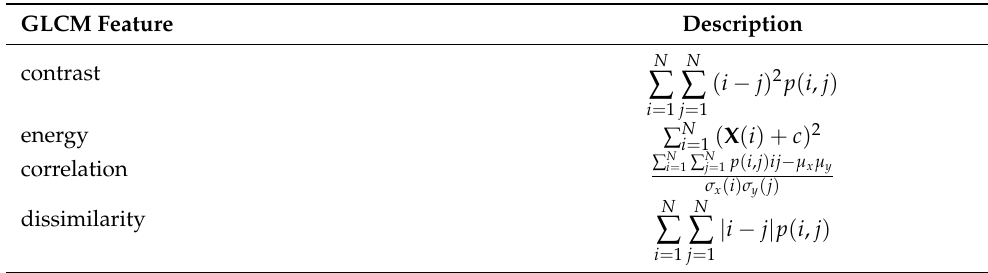
Table A2. Second-order Texture Features. The metrics are computed based on the gray-level co- occurrence matrix for a set of N gray level of pixels inside of the